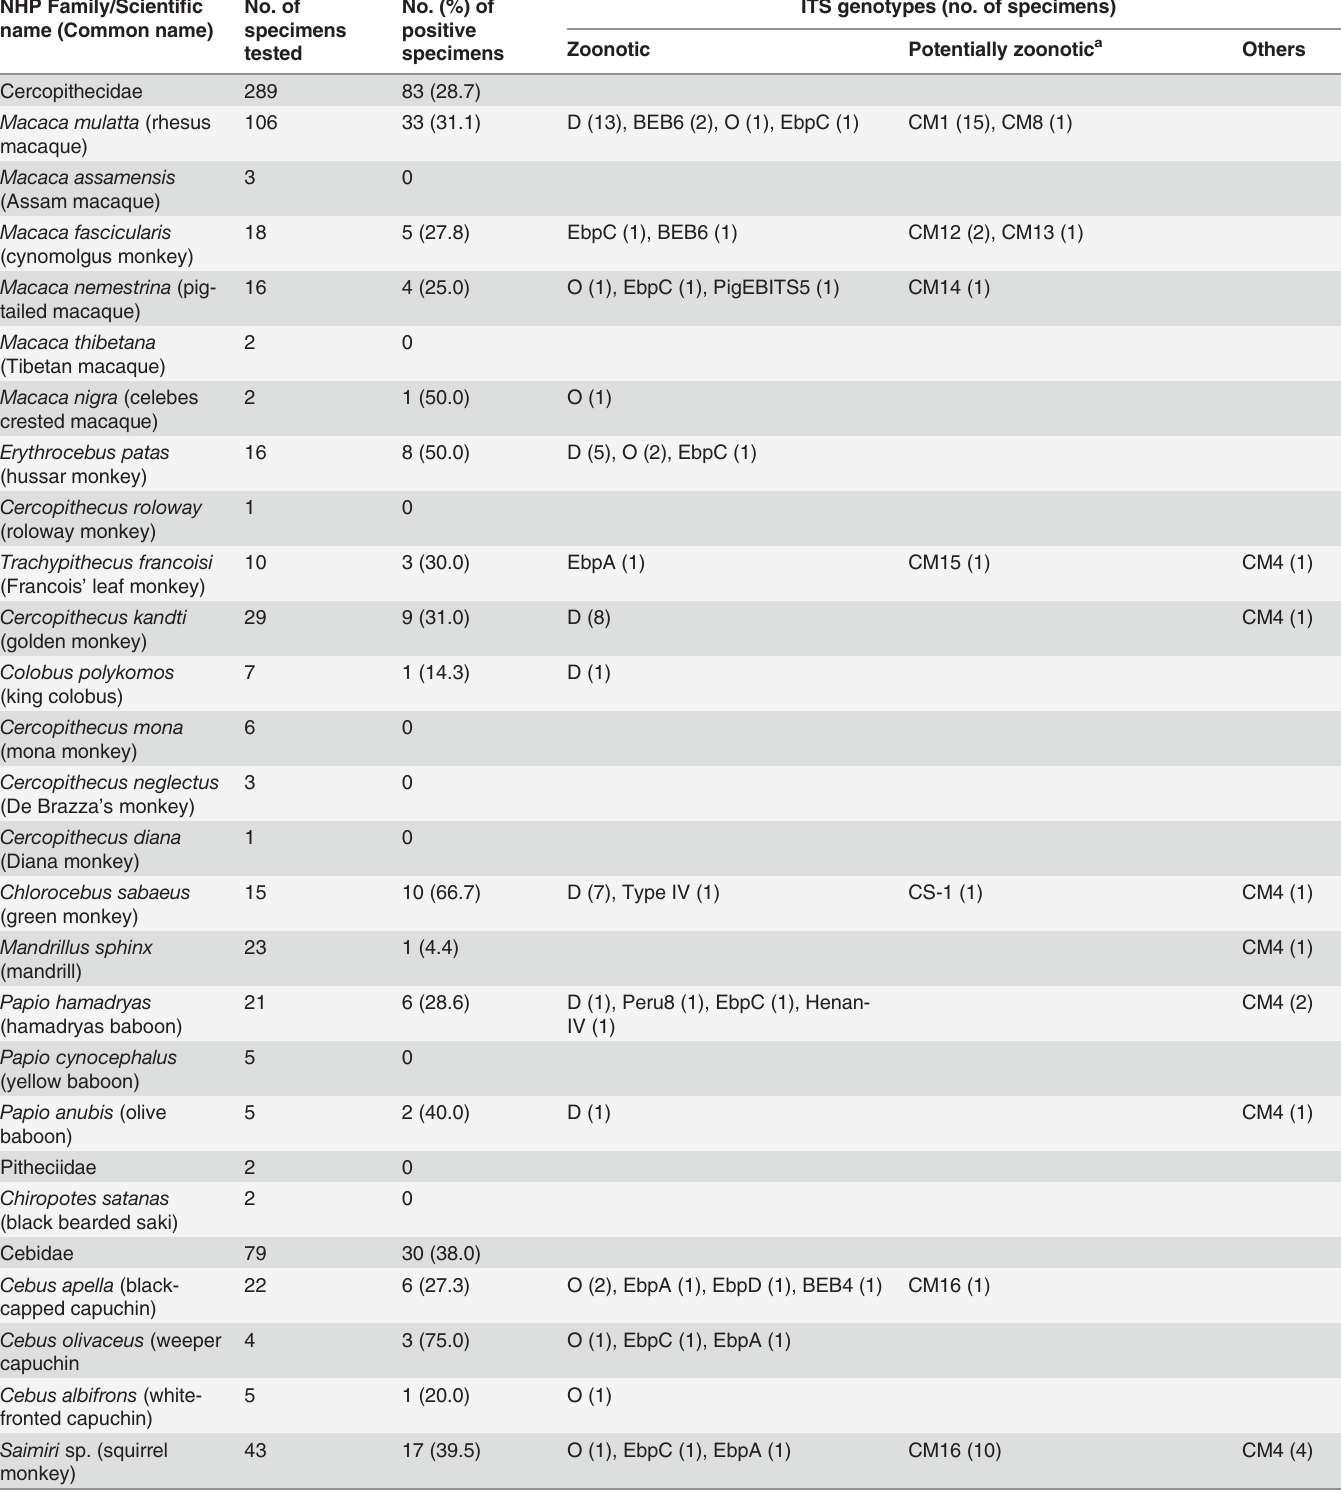
Table 2. Infection rate and genotypes of E . bieneusi in nonhuman primates based on PCR and sequence analysis of ITS